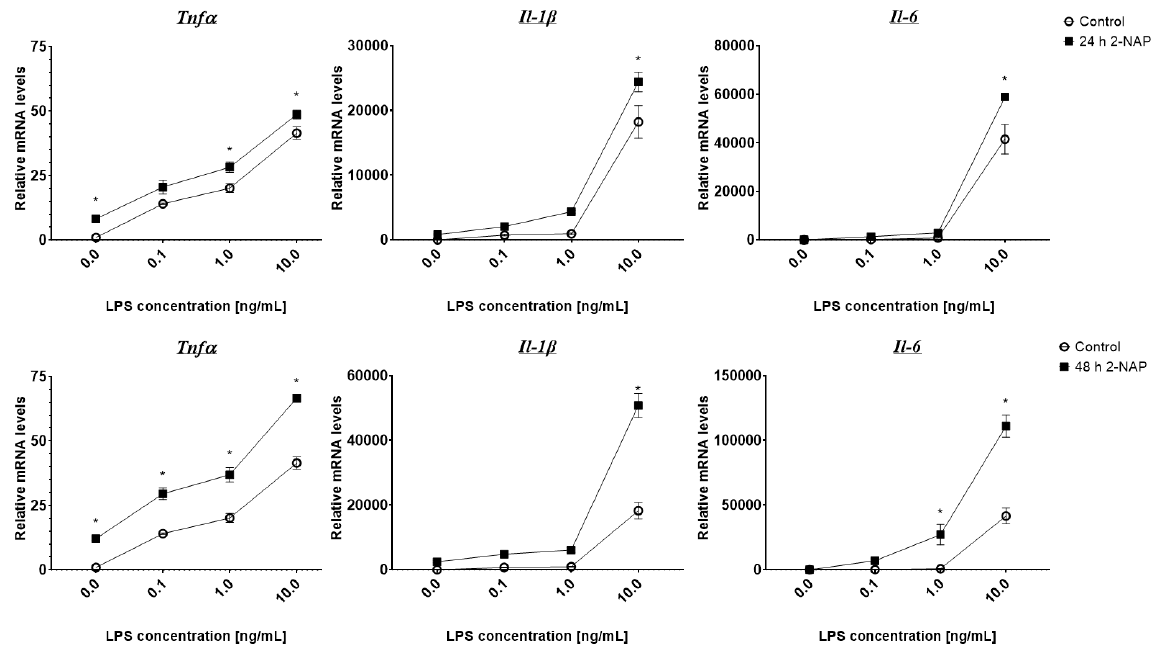
Figure 2. Chronic 2-NAP treatment of RAW264.7 macrophages upregulates mRNA expression of proinflammatory cytokines. ( A,B ) Relative mRNA expression levels of proinflammatory markers ( T nfα , Il- 1β , and Il-6 ) in cells treated with 2-NAP (1 µM) for 24 ( A ) and 48 ( B ) hours. RAW264.7 macrophages were first treated with or without 1 µM 2-NAP for 24 ( A ) or 48 ( B ) hours, and then challenged with different concentrations of LPS as indicated for 4 h. Upon experimental termina- tion, mRNA was extracted and relative gene expression of T nfα , Il- 1β , and Il-6 mRNA was then determined by RT-PCR ( n = 4). The values shown represent the mean ± SEM. * Denotes p < 0.05 when compared with controls. 3.4. Chronic 2-Naphthol Treatment Up-Regulates An Adipogenic and Lipogenic Program Gene Expression in 3T3-L1 Cells Next, we sought to investigate the effects of 2-NAP on adipogenesis and lipid metab- olism. 3T3-L1 murine preadipocytes were induced to differentiate with a differentiation medium and were concurrently treated with either PBS or 2-NAP on days 1 – 2, 3 – 5, 6 – 8, or 1 – 8 of differentiation. Cells from all treatment groups were harvested on day 8 of dif- ferentiation. Adipocytes exposed to 2-NAP during differentiation show an overall in- crease in adipogenesis (Figure 3). More specifically, chronic 2-naphthol treatment, espe- cially during the entire 1 – 8 days of differentiation, upregulated 3T3-L1 adipogenesis, as shown by increased mRNA expression of adipogenic markers such as peroxisome prolif- erator-activated receptor gamma ( Pparγ ), CCAAT enhancer binding protein α ( Cebpα ), and adipocyte protein 2/fatty acid binding protein 4 ( aP2/Fabp4 ) (Figure 3). Additionally, chronic 2-NAP treatment from days 1 – 8 increased the expression of a key lipogenic en- zyme, fatty acid synthase ( Fasn ), while coordinately downregulating genes involved in lipolysis, including the significant downregulation of hormone-sensitive lipase ( Hsl ) and the tendency of downregulation of patatin-like phospholipase domain containing 2/adi- pocyte triglyceride lipase ( Pnpla2/Atgl ) (Figure 3). Moreover, chronic 2-NAP treatment during differentiation significantly decreased the adipokine adiponectin ( Adipoq ) expres- sion (Figure 3). In 3T3-L1 cells treated with 2-NAP during the differentiation days 6 – 8, there was also an increase in Fasn expression and a coordinated decrease in Hsl expression (Figure 3). Thus, our data suggest that chronic 2-NAP treatment in adipocytes may